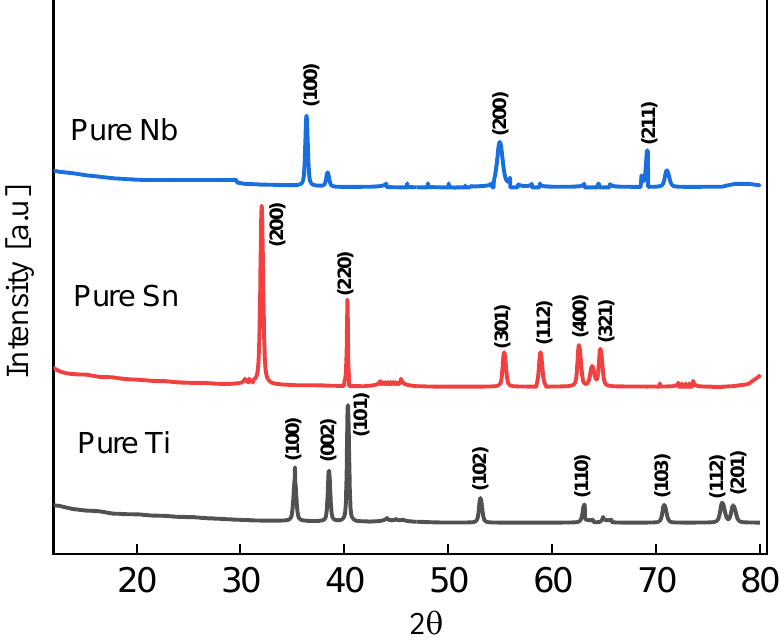
Figure 1. XRD of pure Nb shown as blue line, XRD of pure Sn shown as red line, and XRD of pure Ti indicated by black line.